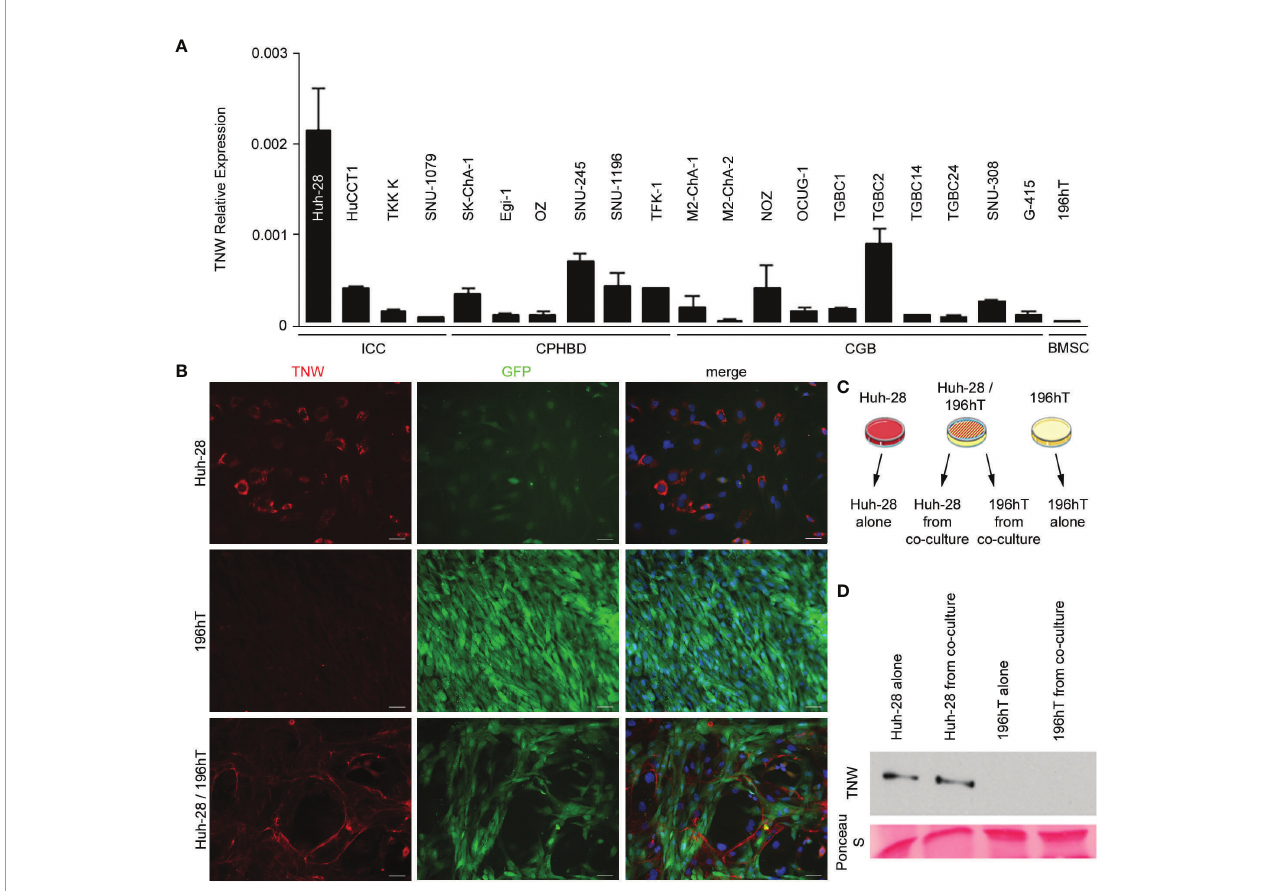
FIGURE 4 | Expression of tenascin-W by cell lines derived from biliary tract tumors. (A) Twenty cell lines were analyzed for tenascin-W expression using qRT-PCR. The results were plotted as expression relative to that of the housekeeping gene hTBP. Four cells lines were derived from intrahepatic cholangiocarcinomas (ICC), 6 were from carcinoma of perihilar bile ducts (CPHBD), and 10 were from carcinoma of the gallbladder (CGB). For comparison, qRT-PCR expression of tenascin-W by a bone marrow stromal cell-derived cell line (196hT) is shown. The highest level of tenascin-W expression was seen in the ICC-derived cell line Huh-28; (B) Immunocytochemistry with anti-tenascin-W (TNW) reveals intracellular labeling of Huh-28 cells, but not 196hT cells. The 196hT cells, but not the Huh-28 cells, express GFP. The merged images include a DAPI nuclear counterstain. When the two cell lines are co-cultured, tenascin-W-positive fi brils surround nests of Huh-28 cells, mimicking the arrangement of tenascin-W in the stroma of ICCs. Scale bars = 50 m m. (C) The method used for separating Huh-28 cells from GFP-positive 196hT cells following co-culture is shown schematically. Illustration was created using Servier Medical Art Powerpoint Image Bank (Servier, https://smart.servier.com/). (D) Tenascin-W can be detected by immunoblotting with 30µg of cell lysates of Huh-28 cells and Huh-28 cells following co-culture with 196hT cells. Tenascin-W is not detectable in the lysates of 196hT cells or 196hT cells following co-culture. Ponceau S was used as a loading